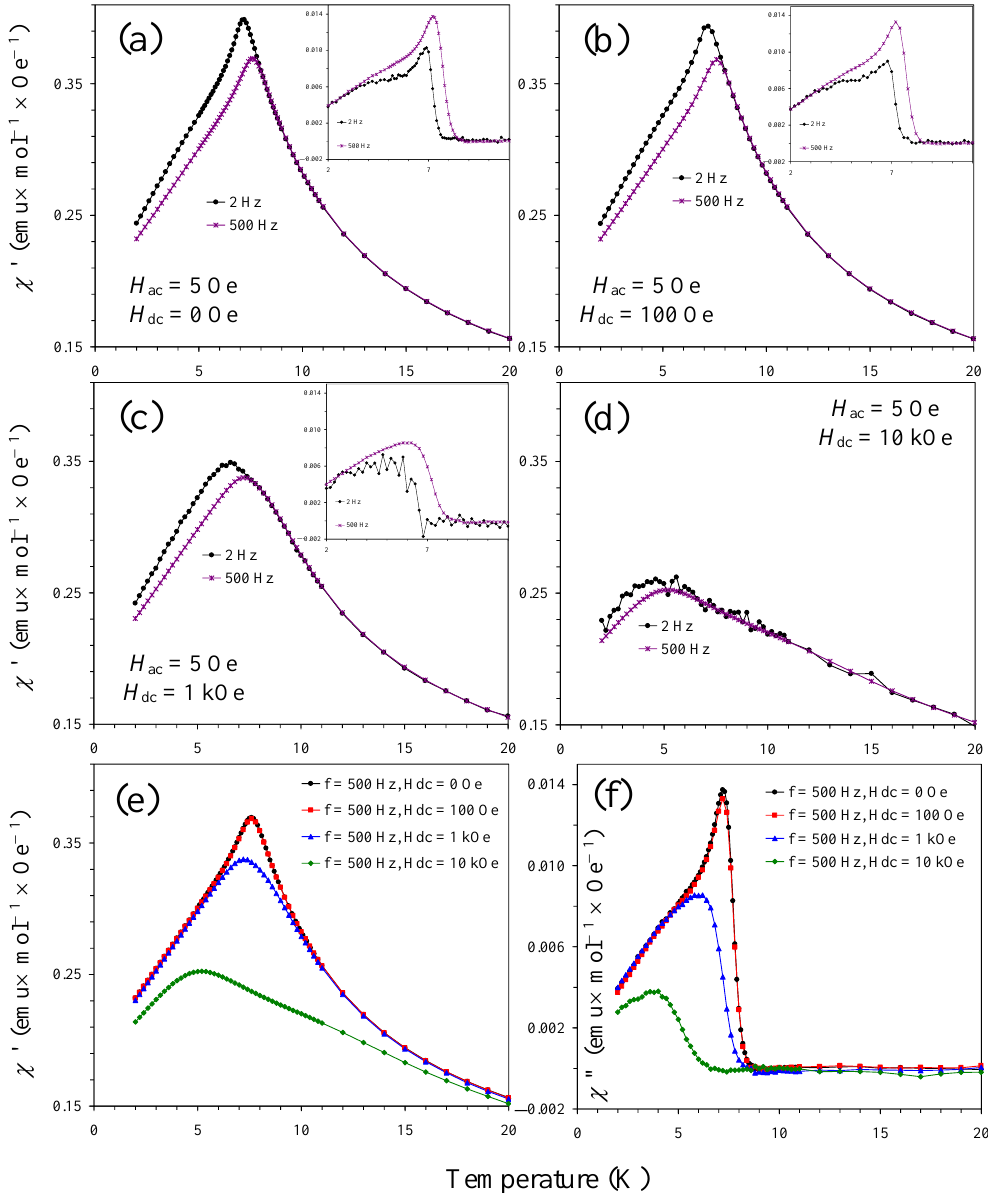
Figure 7. ( a – d ) χ′ versus T curves of Sm 2 CuMn(MnTi 3 )O 12 at f = 2 Hz and 500 Hz and different bias Figure 7. ( a – d ) χ (cid:48) versus T curves of Sm 2 CuMn(MnTi 3 )O 12 at f = 2 Hz and 500 Hz and different bias dc fields: ( a ) H dc = 0 Oe, ( b ) 100 Oe, ( c ) 1 kOe, and ( d ) 10 kOe. Insets show χ″ versus T curves (the χ″ dc fields: ( a ) H dc = 0 Oe, ( b ) 100 Oe, ( c ) 1 kOe, and ( d ) 10 kOe. Insets show χ (cid:48)(cid:48) versus T curves (the data at f = 2 Hz and H dc = 10 kOe were too noisy and not shown). ( e ) All χ′ versus T curves at f = 500 χ (cid:48)(cid:48) data at f = 2 Hz and H χ (cid:48) versus T curves at dc = 10 kOe were too noisy and not shown). ( e ) All Hz are shown in one figure. ( f ) All χ″ versus T curves at f = 500 Hz are shown in one figure. f = 500 Hz are shown in one figure. ( f ) All χ (cid:48)(cid:48) versus T curves at f = 500 Hz are shown in one figure. Sm 2 CuMn(MnTi 3 )O 12 shows time-dependent magnetic properties below T SG , namely The temperature dependence of the dielectric constant and dielectric loss is shown magnetization relaxation (Figure 8). Above T SG , no noticeable relaxation of magnetization in Figure 10. The dielectric constant was nearly temperature and frequency-independent was detected. Time-dependent magnetic properties, such as relaxation, are typical fea- between 8 and 200 K. Above about 200 K, a sharp rise in the dielectric constant was tures of spin-glass systems. Relaxation below T SG was fitted by the stretched exponential observed, where the magnitude of the rise depended on frequency. This behavior typically function, f ( t ) = M 0 − M SG  exp[ − ( t / t r ) β ] [30], and the resultant parameters are listed on Table originates from the Maxwell–Wagner contribution due to increased conductivity. No 3. The most important parameter is the mean relaxation time, t r , and it decreases mono- broad anomalies were observed in Sm 2 CuMn(MnTi 3 )O 12 in comparison with the parent tonically with increasing temperature. compound Sm 2 MnMn(MnTi 3 )O 12 . This fact shows that Cu 2+ doping drastically modified the dielectric properties as well, in addition to the magnetic properties. We note that Pt impurity was only observed in a powder sample, which could contain parts from